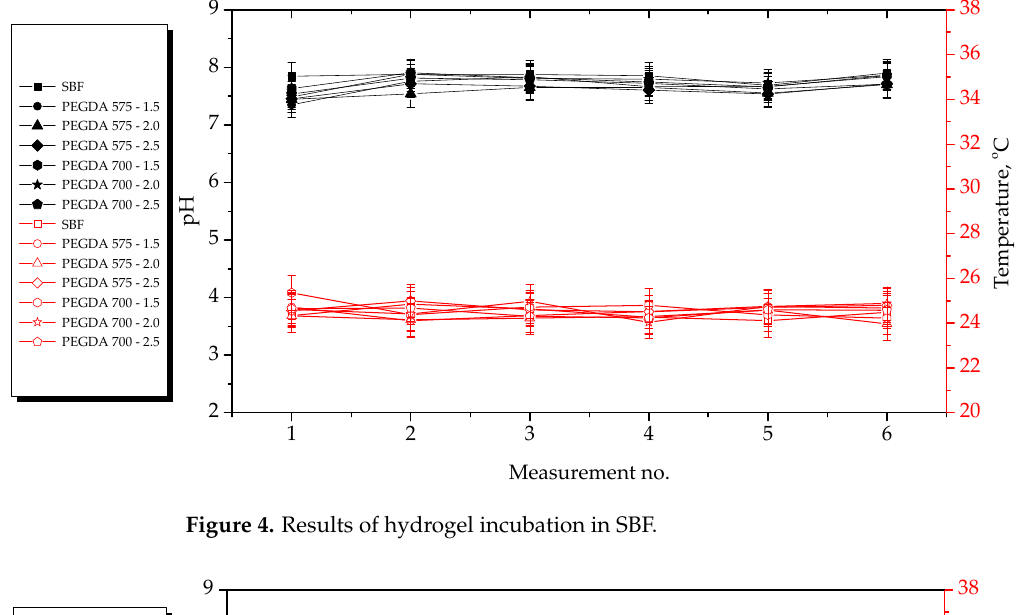
Figure 4. Results of hydrogel incubation in SBF.